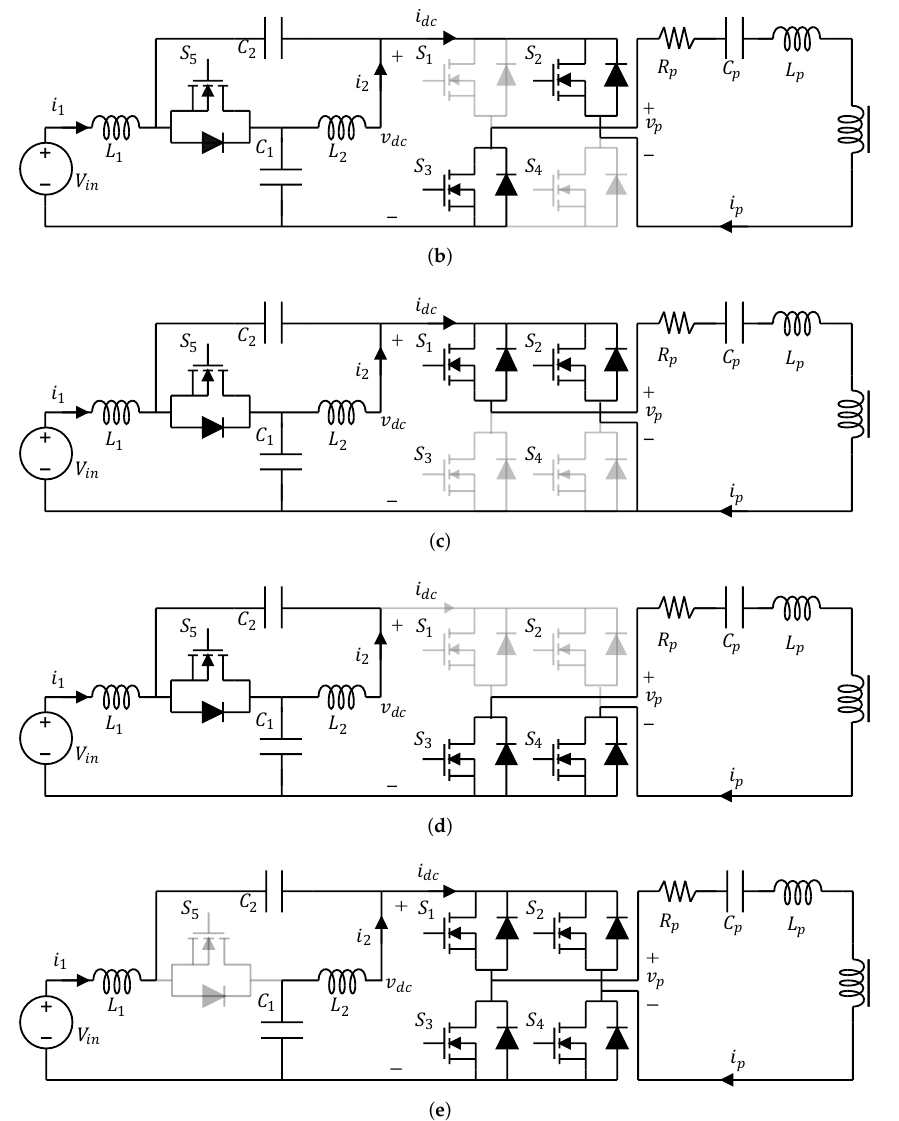
Figure 3. Circuit schematic of the qZS-IPT system in different states. ( a ) Active state S 1 , S 4 . ( b ) Active state S 2 , S 3 . ( c ) Zero state S 1 , S 2 . ( d ) Zero state S 3 , S 4 . ( e ) Shoot-through